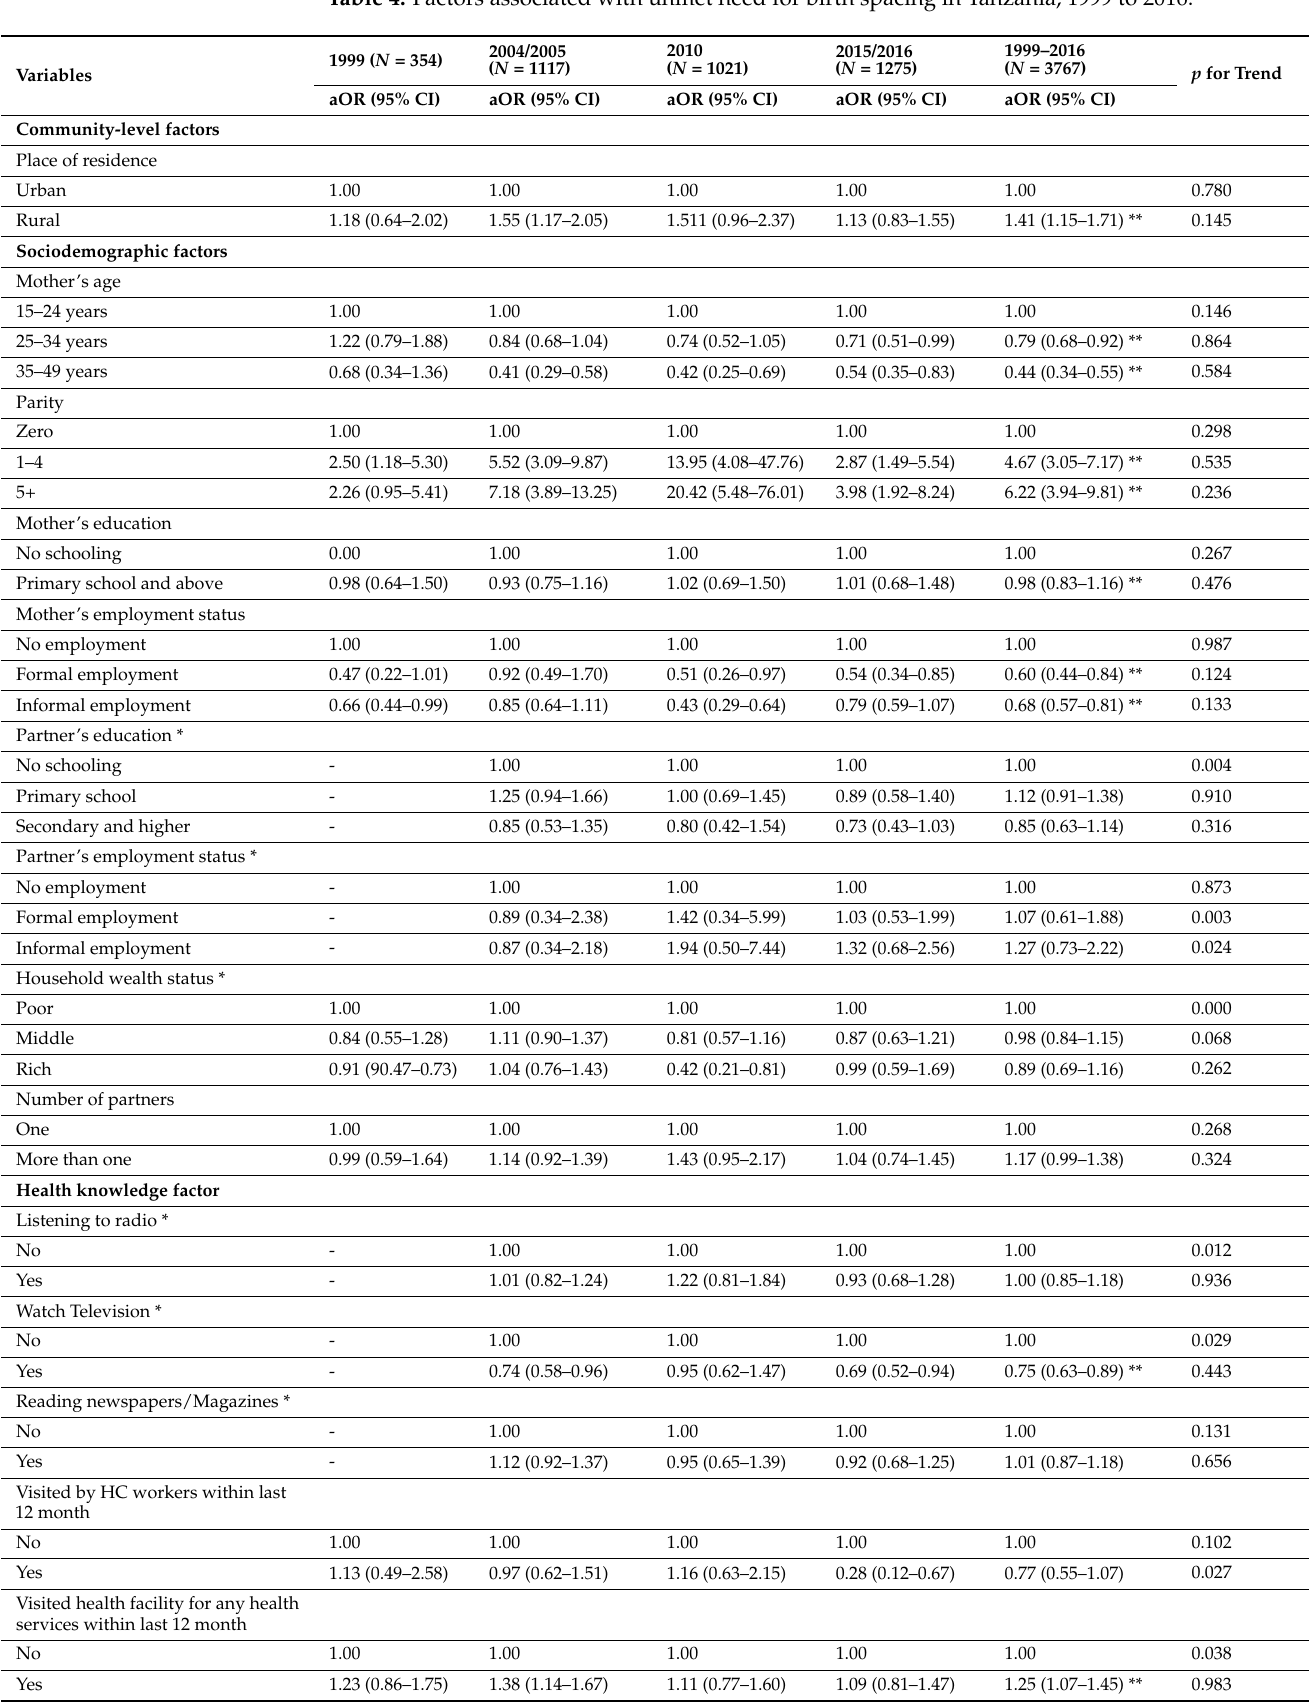
Table 4. Factors associated with unmet need for birth spacing in Tanzania, 1999 to